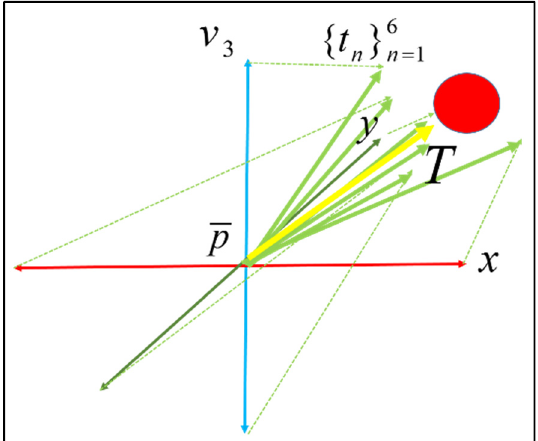
Figure 2. Escape direction estimation: v 3 is the normal vector of the point cloud P merge , the potential initial transformations are allow the 3 axis of x , y and v 3 . Dotted green lines are the transformations estimated by ICP registration and the thick green lines t n are the combination of initial transformation and ICP estimation. Thick yellow line represent of the combination of t n , and red ball is desired registration.